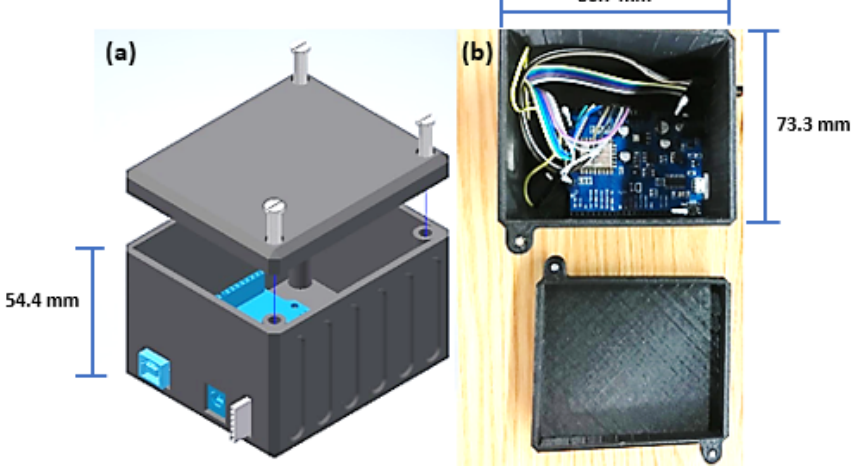
Figure 8. Central processing unit (CPU) subsystem and communication interfaces. ( a ) Isometric CAD view; ( b ) manufactured